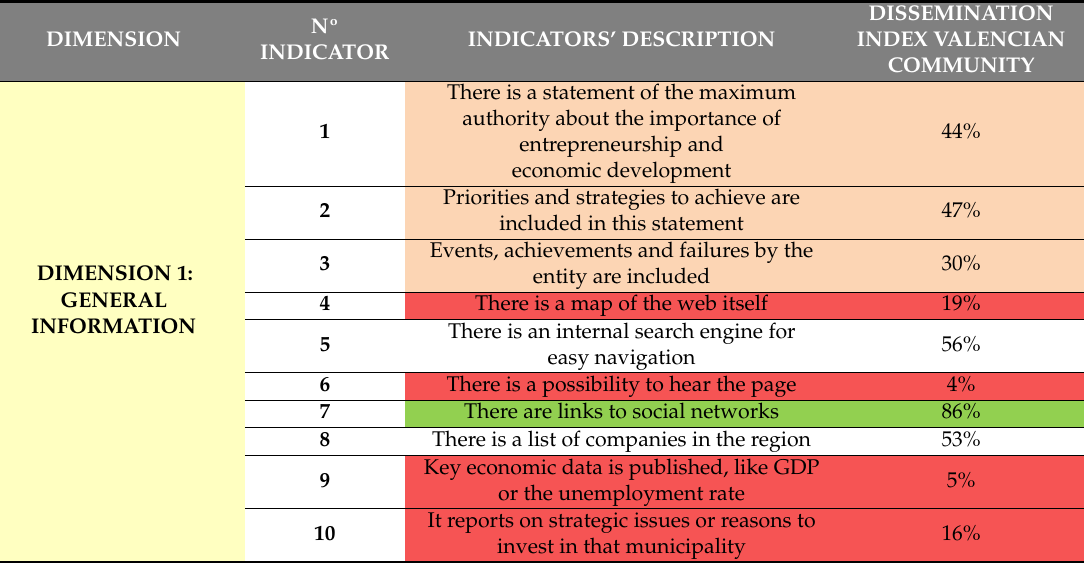
Table 4. Results of the indicators of the dissemination index classified in urgency (own